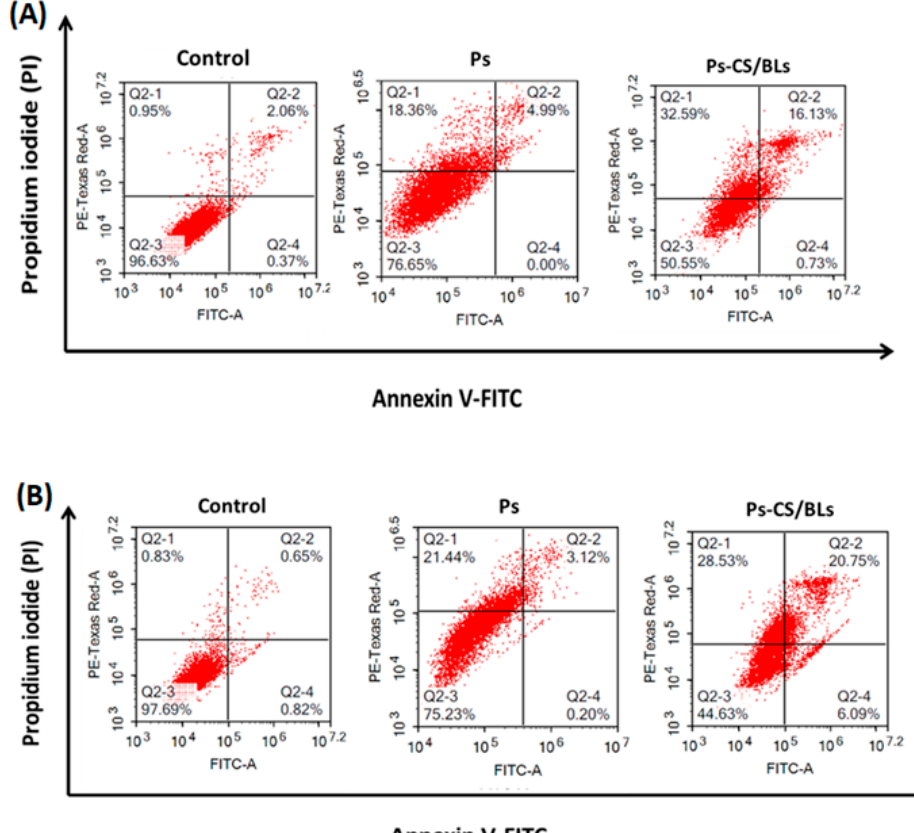
Figure 8. Apoptotic and necrotic effects of free and loaded Ps on ( A ) MCF-7 and ( B ) A549 cells. This figure represents a representative figure from flow cytometric analysis experiments and the apoptotic assay. This experiment was performed in